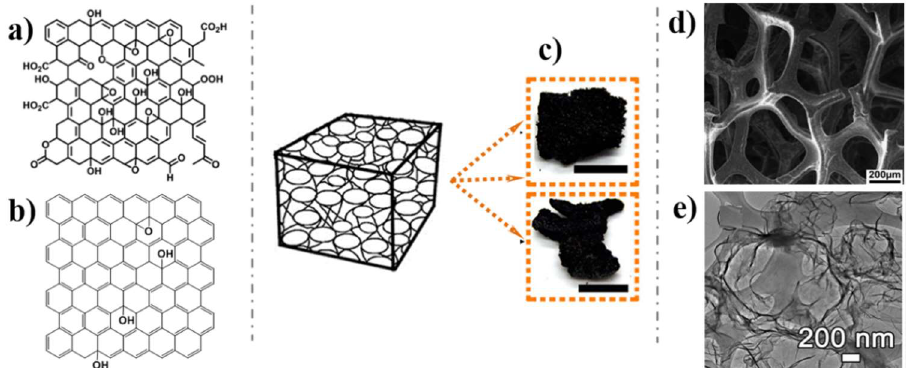
Figure 2. Schematic illustration of 2D graphene film defined according to their oxidation functional groups: ( a ) GO; ( b ) RGO; 3D graphene architectures: ( c ) Photographs; ( d ) Scanning electron microscope (SEM) image; ( e ) Transmission electron microscope (TEM) images. Reproduced from [40] ( a ), with permission from The Royal Society of Chemistry, 2014; Reproduced from [37] ( c , e ), with permission from American Chemical Society, 2017; Reproduced from [38] ( d ), with permission from American Chemical Society, 2012.